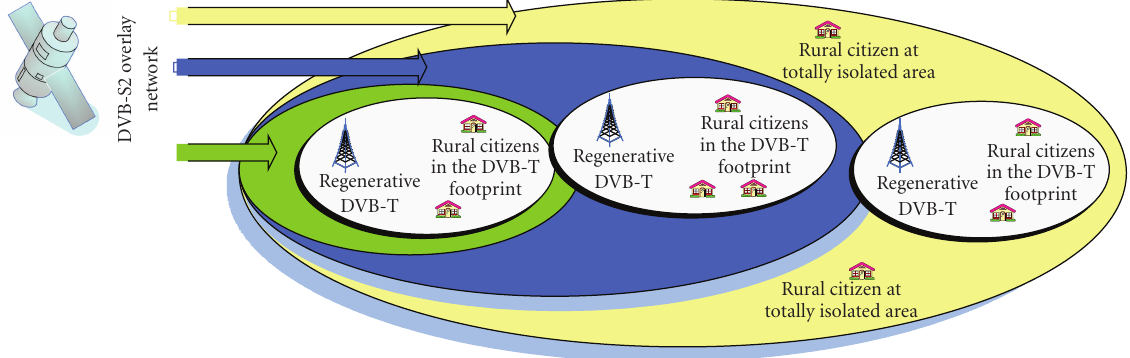
Figure 1: Overall architecture of the hybrid terrestrial/satellite